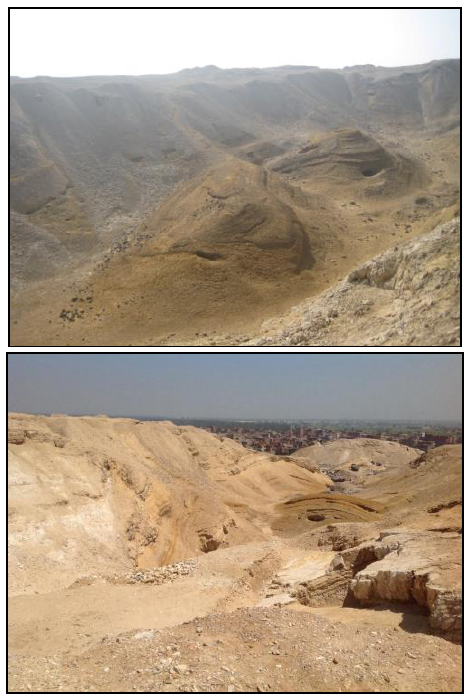
Figure 4a and b: Over view for the area, showings the anticline and syncline folds with alternative beds of sandstone and limestone. S, sinkholes also appear in the folded strata.